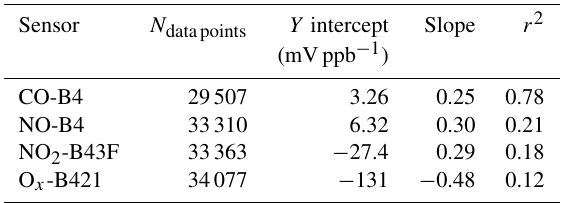
Table 1. Performance metrics for raw sensor output versus refer- ence